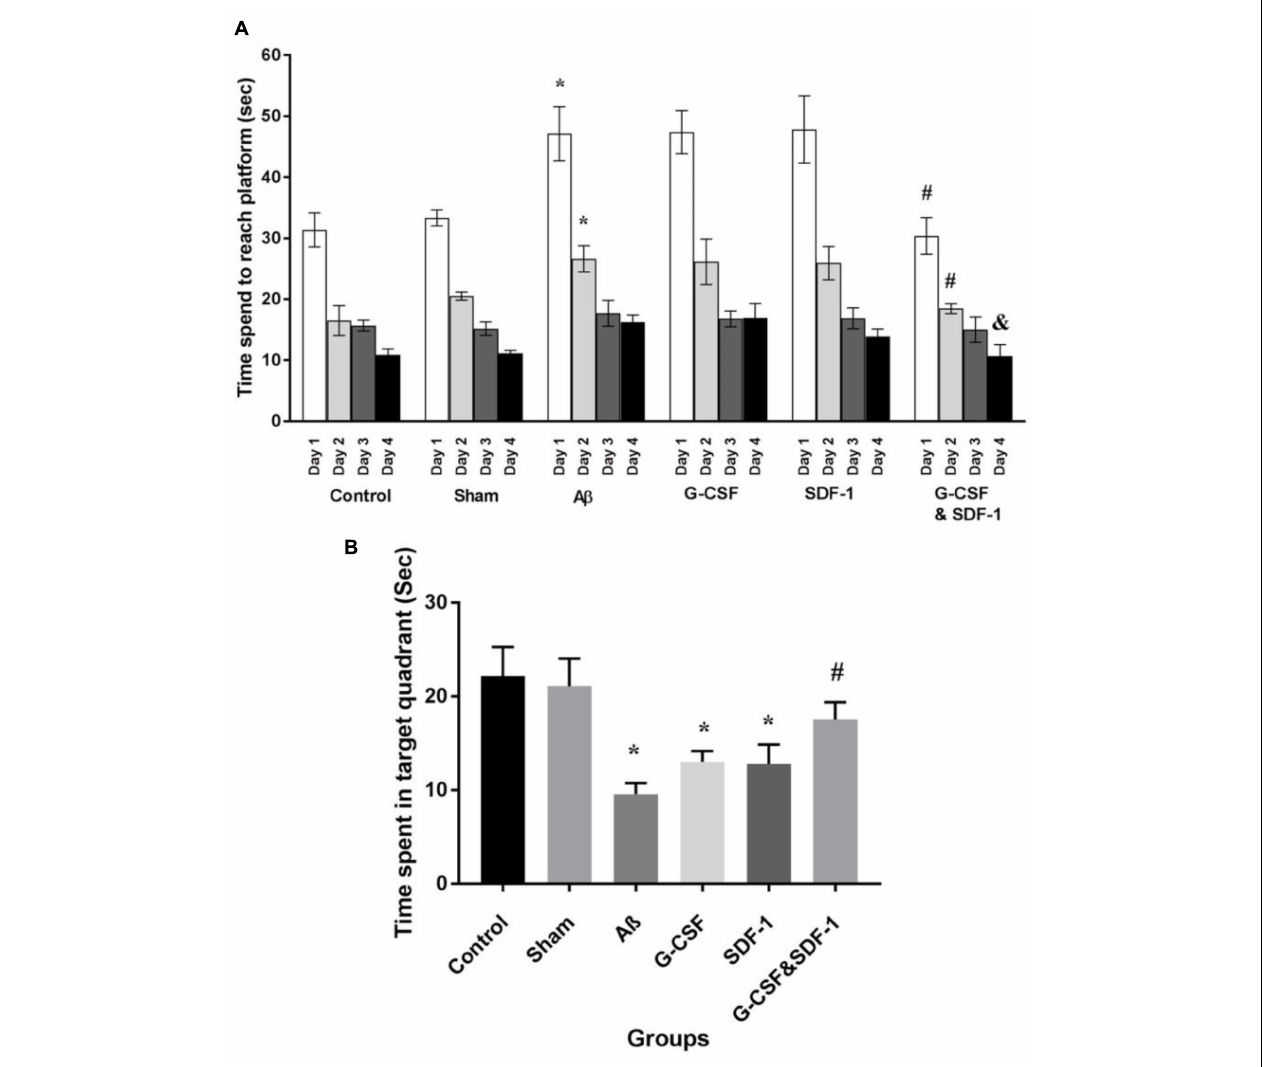
FIGURE 4 | Effect of SDF-1 and G-CSF treatment in the Morris Water Maze test. (A) Time spend to find platform during learning days. (B) Time spend in target quadrant in test day. (* P < 0.05) as compared with control and sham groups. (# P < 0.05) as compared with G-SDF and SDF-1 groups. (& P < 0.05) A β group. Each column represents Mean ±